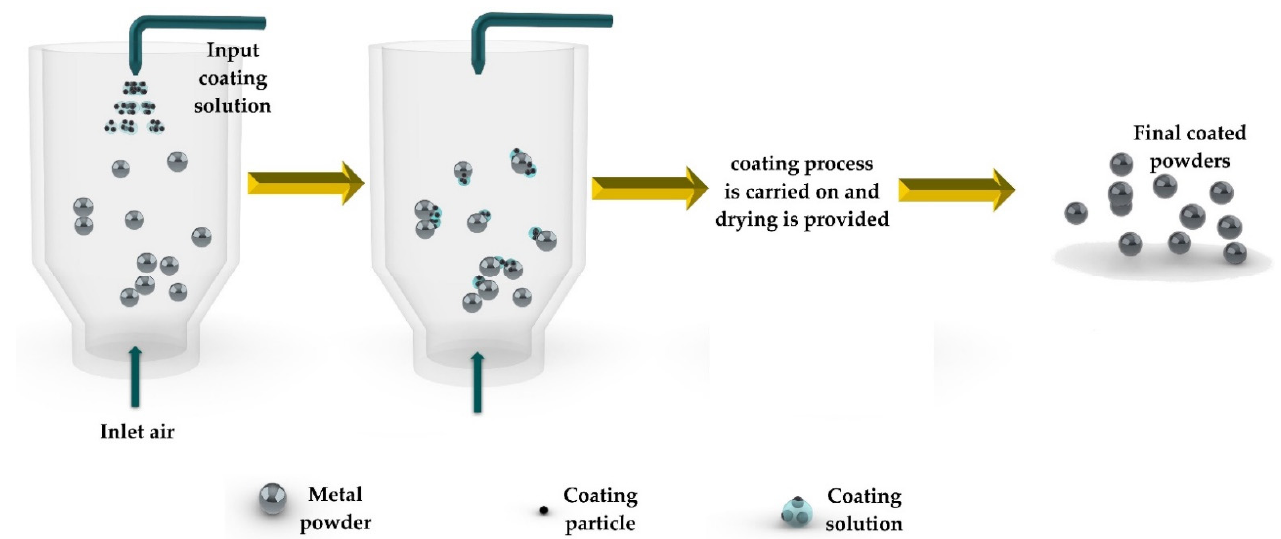
Figure 5. Schematic diagram of fluidized bed process for coating powders, the objects constituting figures are not in scale.